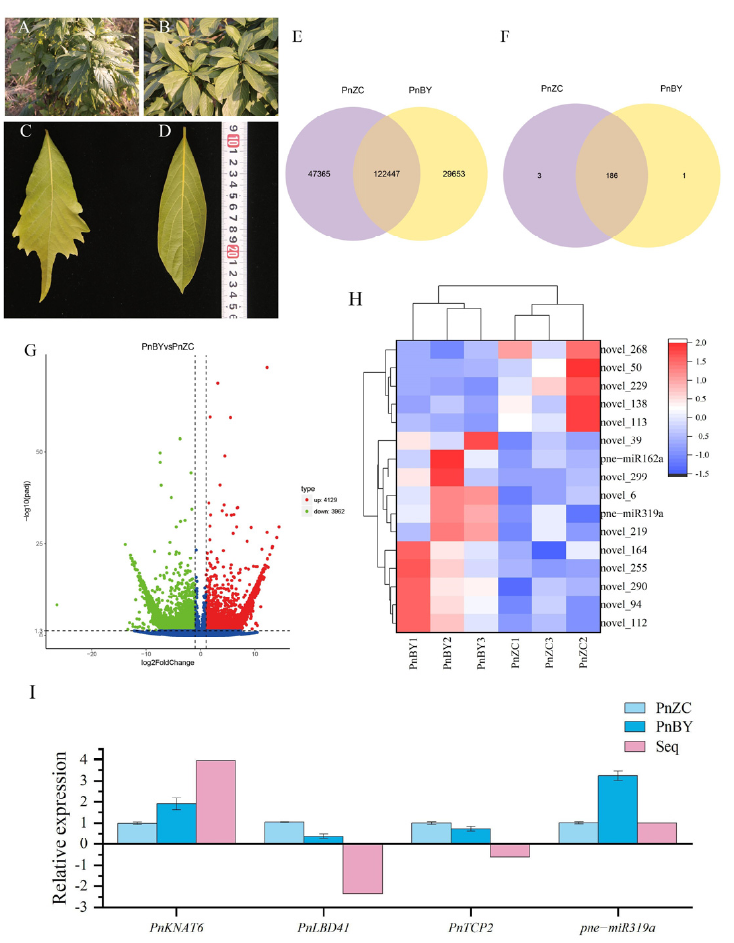
Figure 1. Leaf shape comparison and differential expression analysis between P. neurantha and P. neurantha var. lobophylla. ( A ) Branches of P. neurantha var. lobophylla . ( B ) Branches of P. neurantha . ( C ) A lobed leaf of P. neurantha var. lobophylla . ( D ) Leaf of P. neurantha . ( E ) Venn diagram showing the number of unigenes in PnBY and PnZC. ( F ) Venn diagram showing the number of miRNAs in PnBY and PnZC. ( G ) Volcanic map analysis of DEGs in PnBY. ( H ) Heat map analysis of differentially expressed miRNAs in PnBY. The unit of measurement on the tape is centimeters (cm). ( I ) Expression of leaf-lobed-related genes and miRNA quantified by transcriptome sequencing and qRT-PCR analysis. The standard deviation (SD) was used to measure the error within a group. The significance between samples was compared ( p <